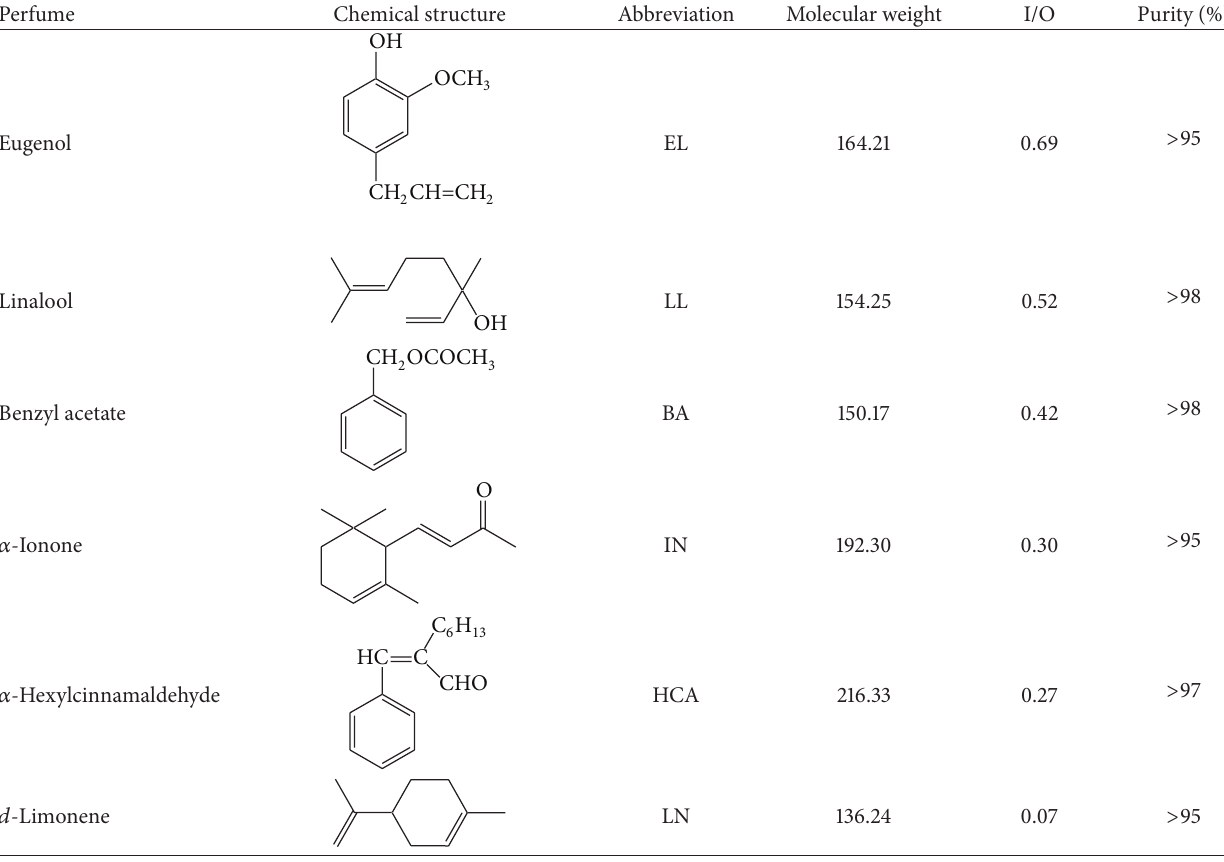
Table 1: Perfumes used in this